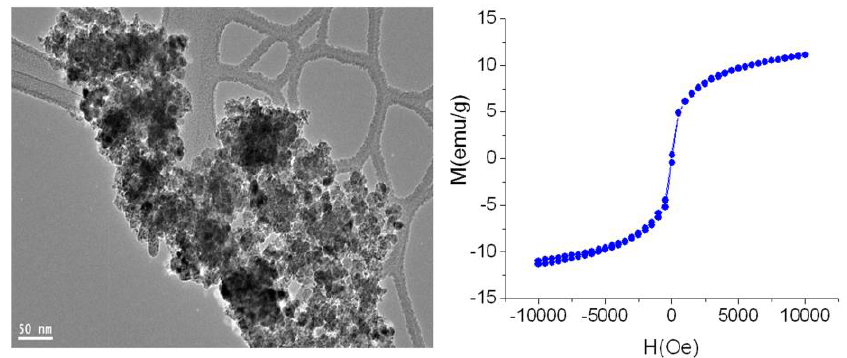
Figure 9. TEM images and magnetization M–H curves of the CoFe 2 O 4 nanoparticles.